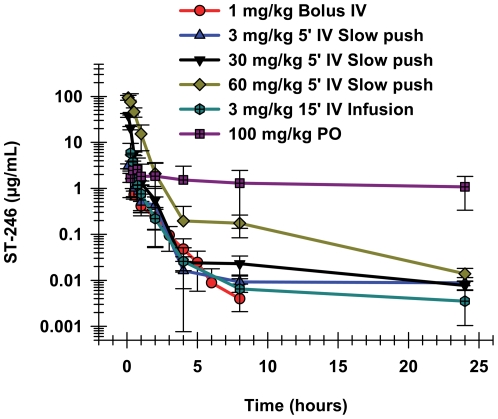
Plasma concentrations over time after IV and oral administration in New Zealand White Rabbits.Plasma concentrations of ST-246 over time are shown after oral administration of 100 mg/kg (purple squares); bolus IV administration of 1 mg/kg (red circles); or a 5- minute IV slow push of 3 (blue triangles), 30 (black triangles), or 60 mg/kg (green diamonds). A 15-minute IV infusion of 3 mg/kg (blue hexagons) is also shown. Each curve is the mean with standard deviations from two male and two female rabbits.